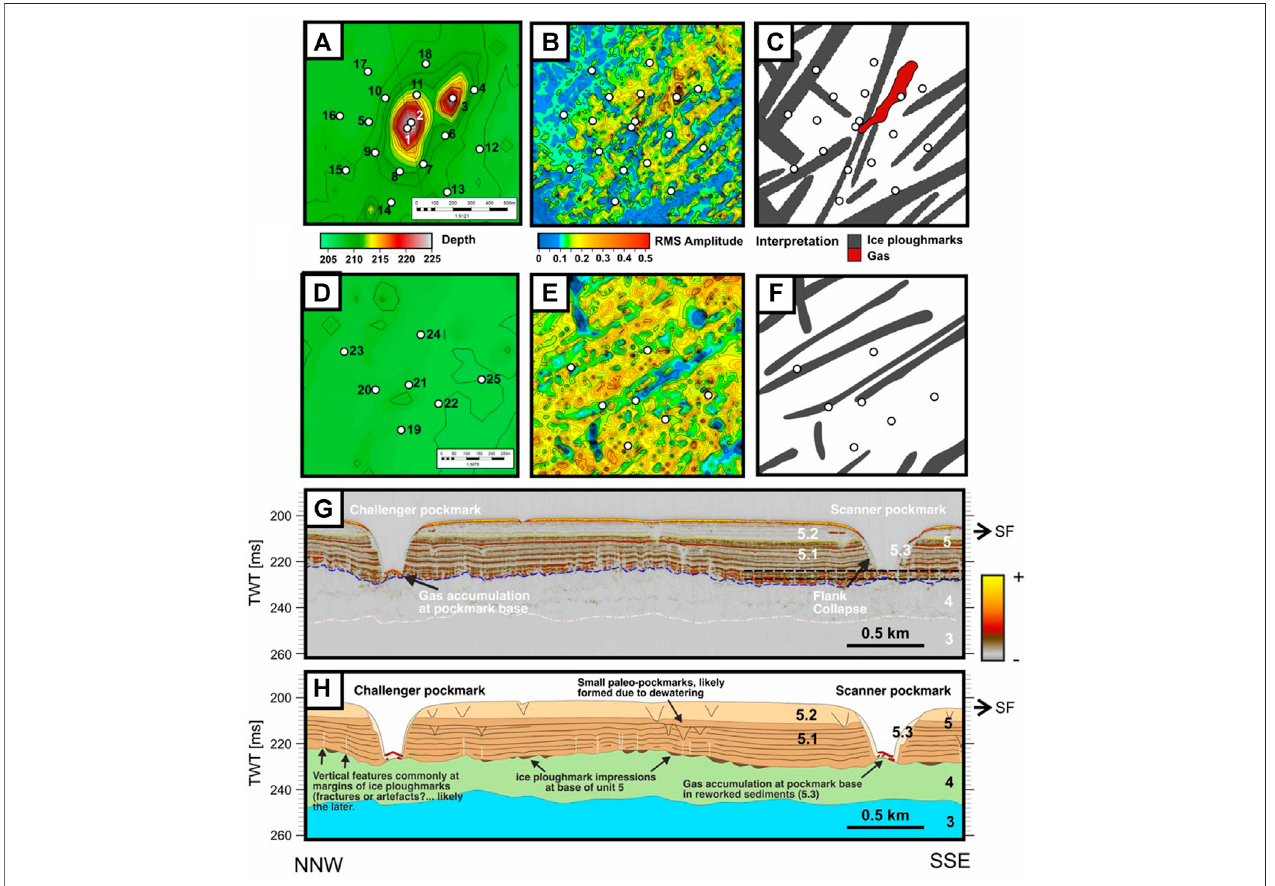
FIGURE 9 | Attribute analysis and interpretation of the Scanner pockmark and reference site. Sub-bottom pro fi ler 2D seismic re fl ection data is used to generate timeslice attributemaps ofseismic unittop S4of (A – C) theScannerPockmark and (D – F) thereferencesite. (A,D) Bathymetrymaps ofseabedwithOBSlocationsand numbersdisplayed. (B,E) RMSamplitudemapsacquiredoveratimewindowof ± 2.5 msaroundthepickedhorizon(225 – 227.5 msTWTfromtheseasurface);theblue areas highlight the spatial extent and orientation of ice ploughmarks. (C, F) Geological interpretation of the surface amplitude maps, highlighting gas-charged sediment (red – high amplitude) and ice ploughmarks(blue – low amplitude). (G – H) Seismic pro fi le extending from north tosouth highlighting the keygeological features of interest.